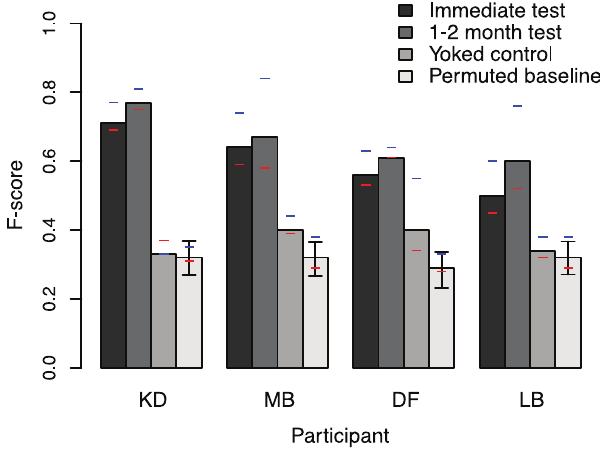
Figure 1. Results of the interim tests. Bars show F-scores (the harmonic mean of precision and recall) for the immediate and 1–2 month test sessions, along with permuted baseline and yoked control scores. Blue and red lines give precision and recall scores respectively for each participant and condition (means for permuted baseline). Error bars show 95% confidence